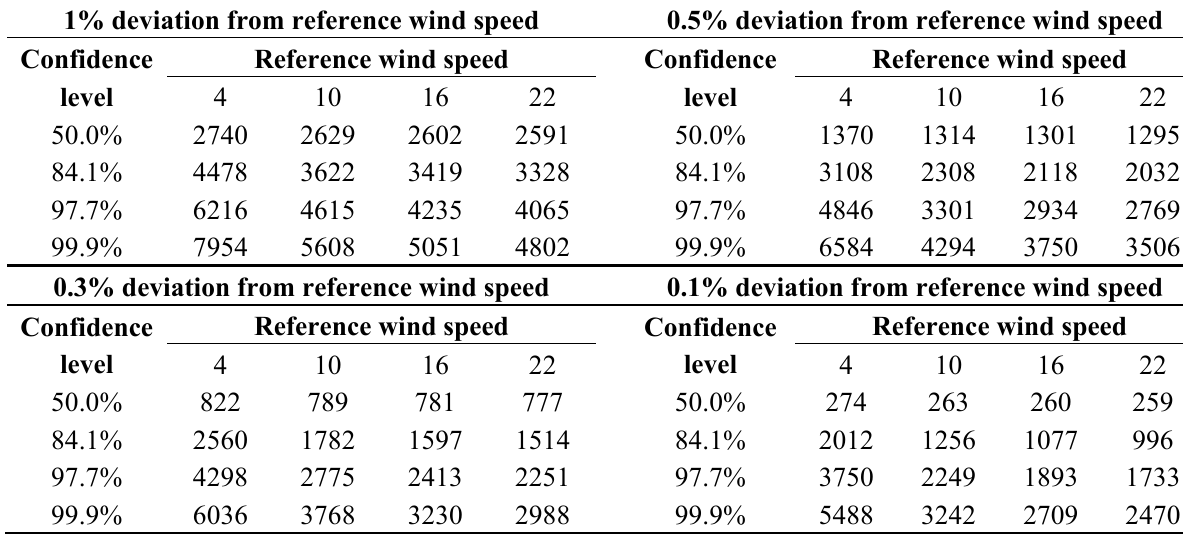
Table 4. Recalibration schedule (days after the initial calibration) of the IDR/UPM confidence